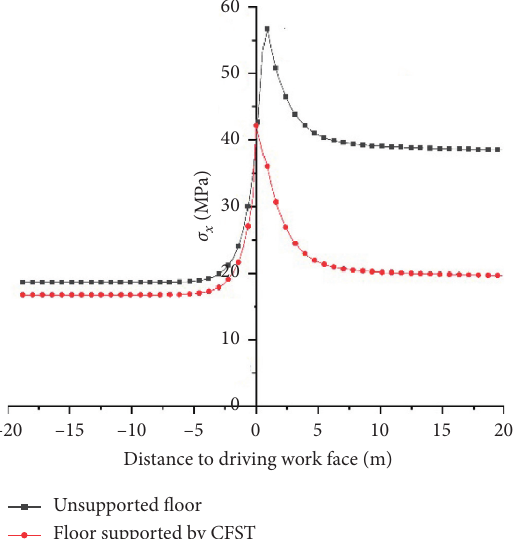
Figure 13: Horizontal stress evolution curve before and after driving working